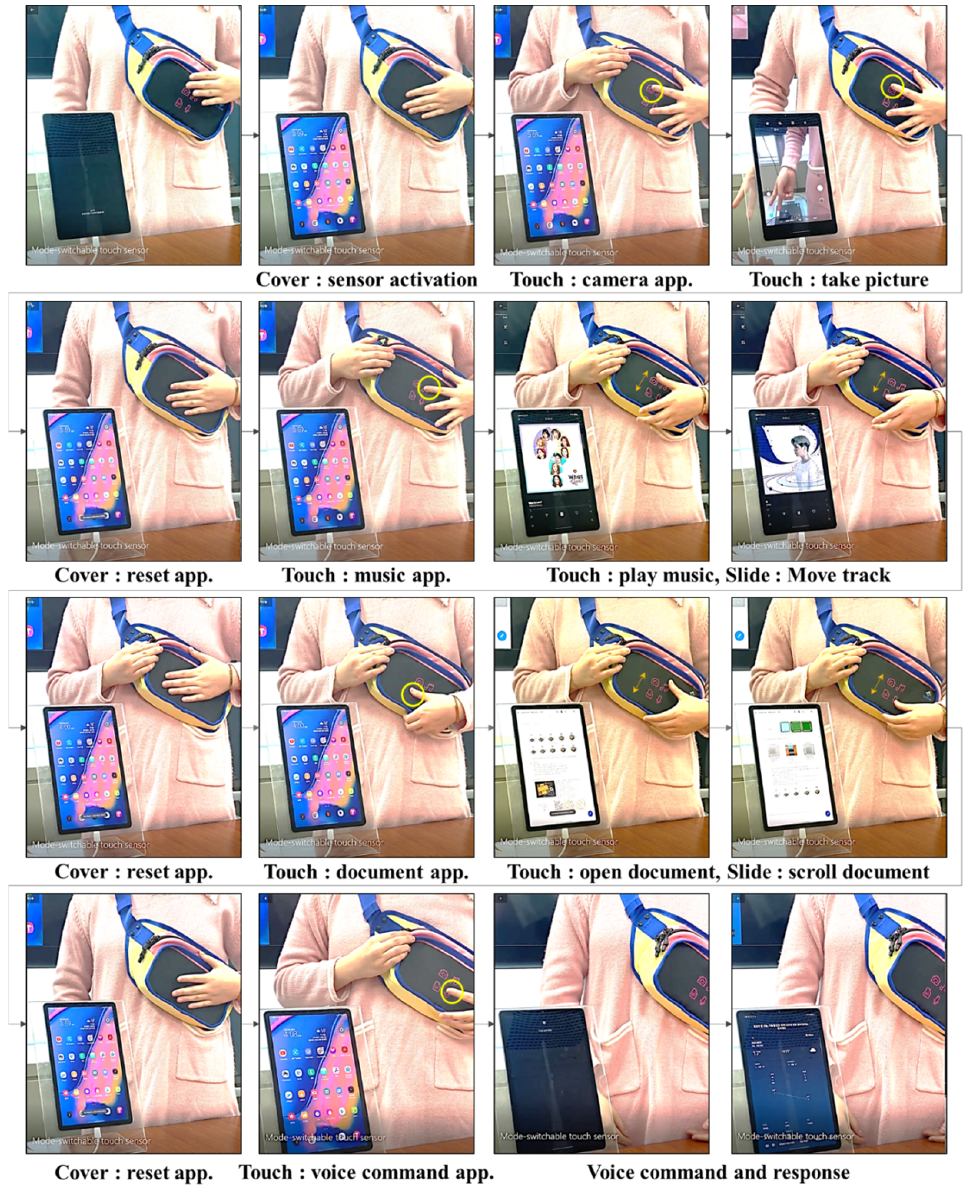
Figure 10. Examples of the operation of the bag prototype with a mode switchable touch sensor.